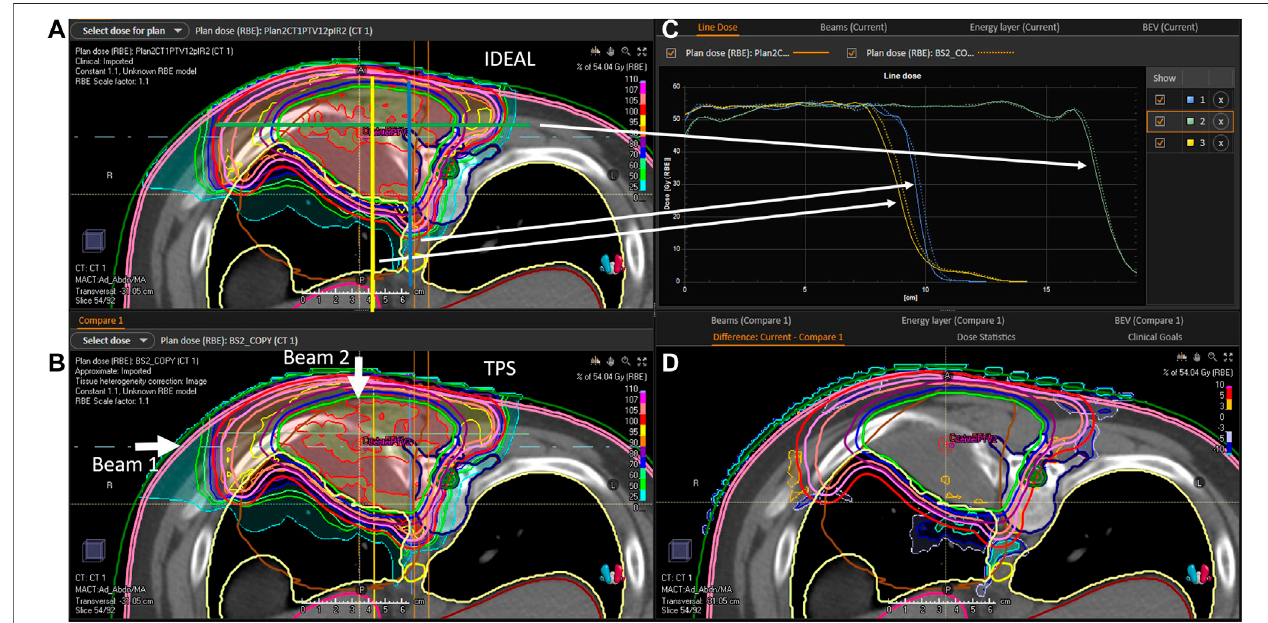
FIGURE5| P2evaluation. (A) :2DIDEALdosedistributioninaCTslice(transversalview), (B) :2DTPSdosedistributioninaCTslice(transversalview), (C) :1Ddose pro fi les extracted from the 2D IDEAL and TPS dose distributions presented on the (A,B) (full line (cid:1) IDEAL, dotted line (cid:1) TPS), (D) : 2D dose difference in a CT slice extracted from the 2D IDEAL and TPS dose distributions presented on the (A,B) (IDEAL — TPS). Beam directions are represented on the (B) picture. On the (A) blue yellow and green lines represent the dose pro fi les presented on the (C) .